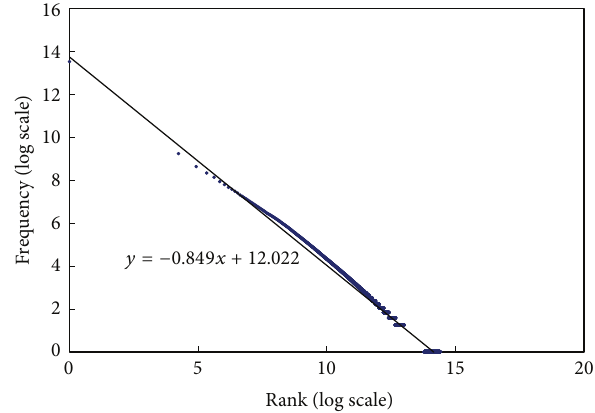
Figure 1: Token frequency as the function of the token’s rank with the word-level 2-grams token model in the TanCorp collection.